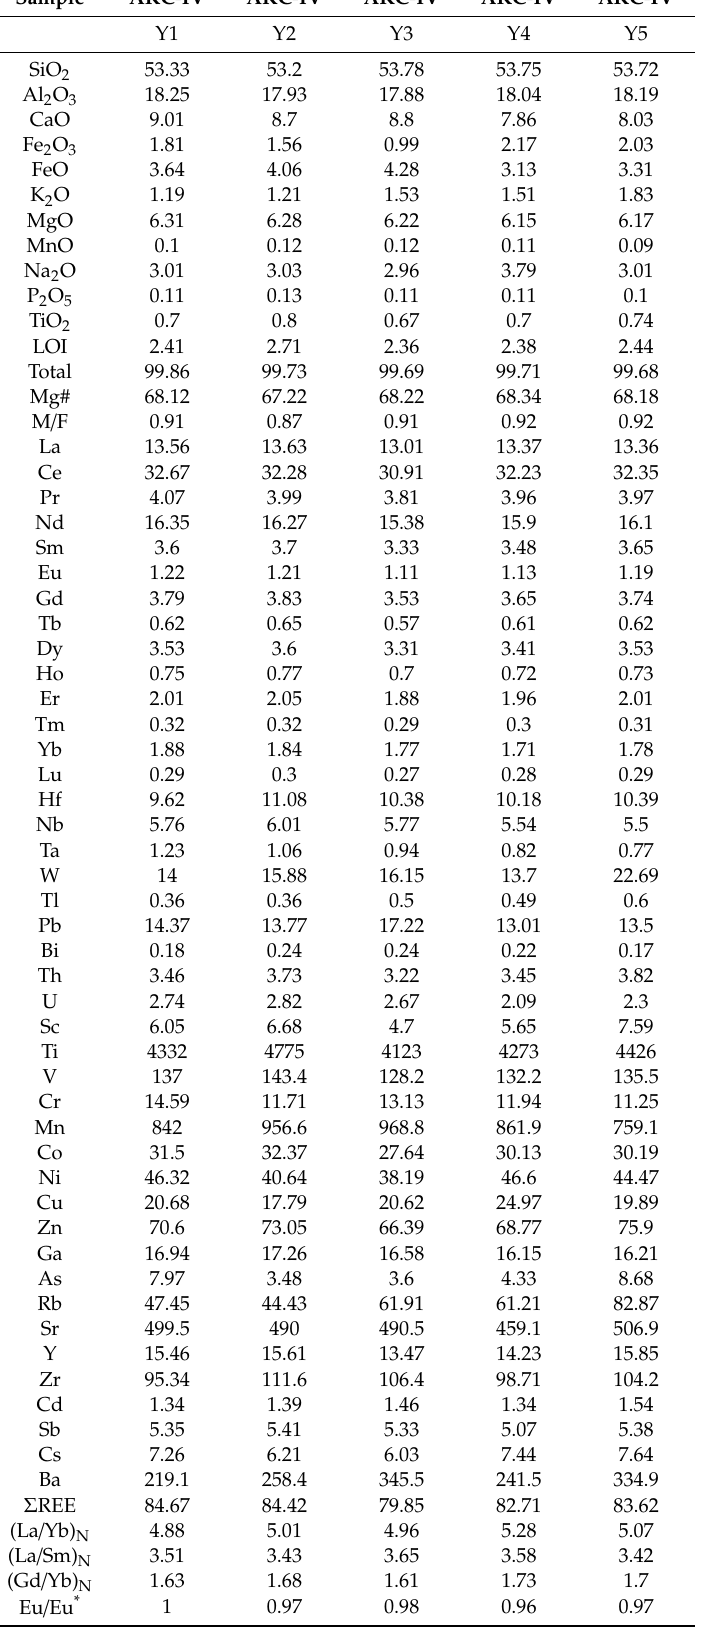
Table 1. Major and trace element compositions of